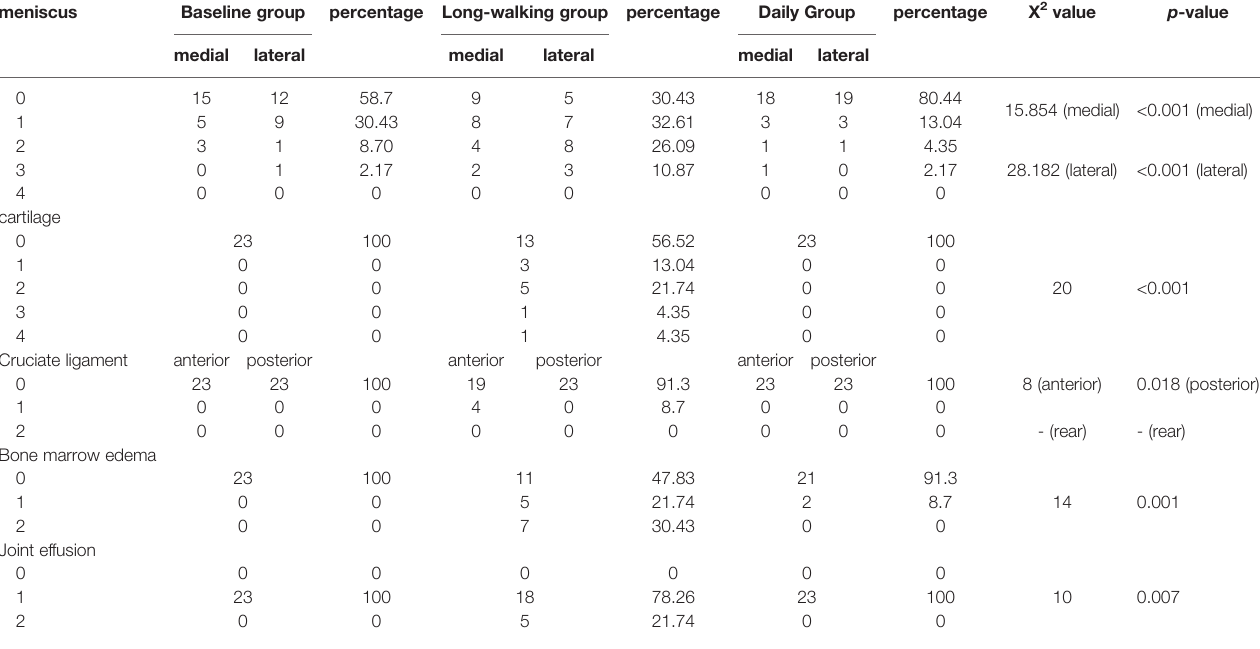
TABLE 2 | Comparison of injurie level in different areas of the knee joint in three groups (n = 23).